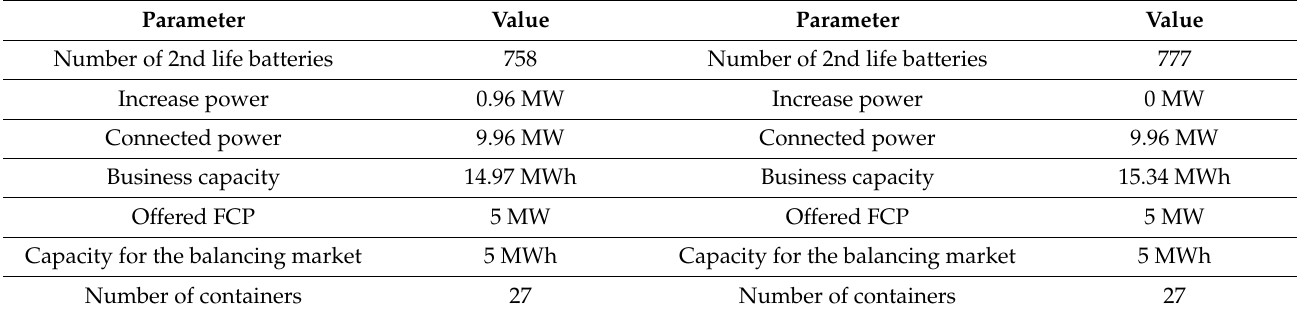
Table 12. Output parameters of the large battery storage strategy after 5 (left) and 10 (right) years.